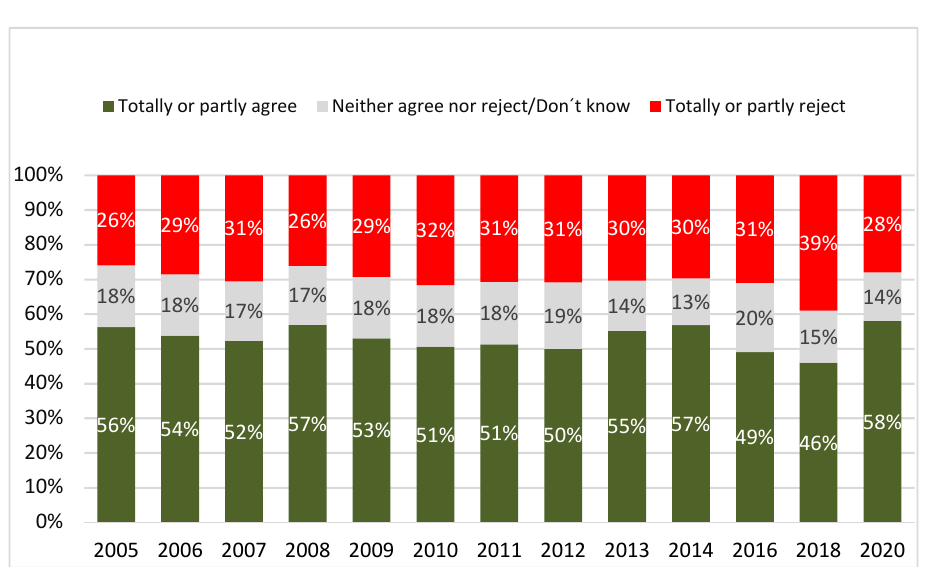
Figure 6. Positive statement about preservation of cultural traditions: The society should create possibilities for people with foreign background to be able to preserve their cultural